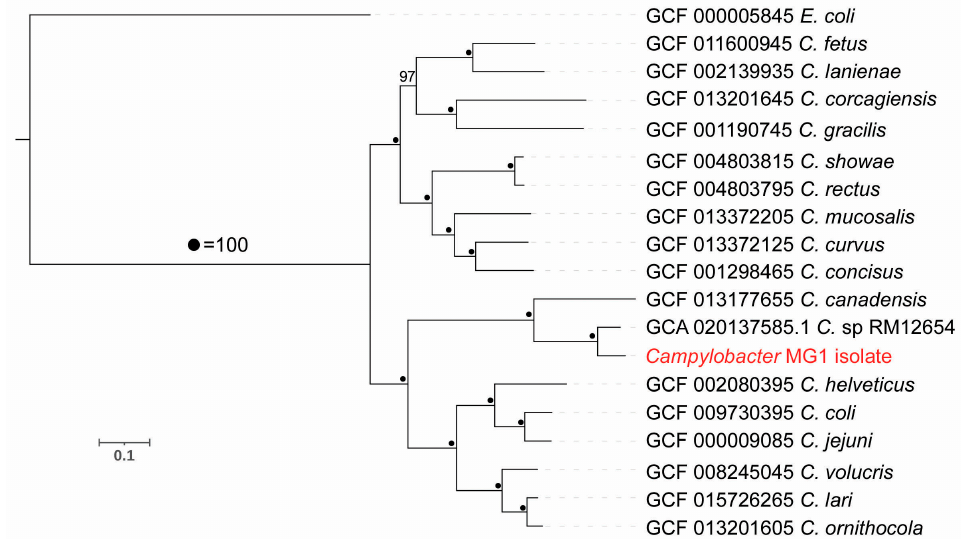
Figure 2. Phylogenomic analysis of the MG1 isolate. The phylogenomic tree was generated using 118 possible single copy genes specific to Proteobacteria and generated via GToTree. Escherichia coli ( E. coli —GCF_000005845) was used to root the tree. Nodes are annotated with bootstrap support (dot = 100% agreement). The scale bar indicates substitutions per site.